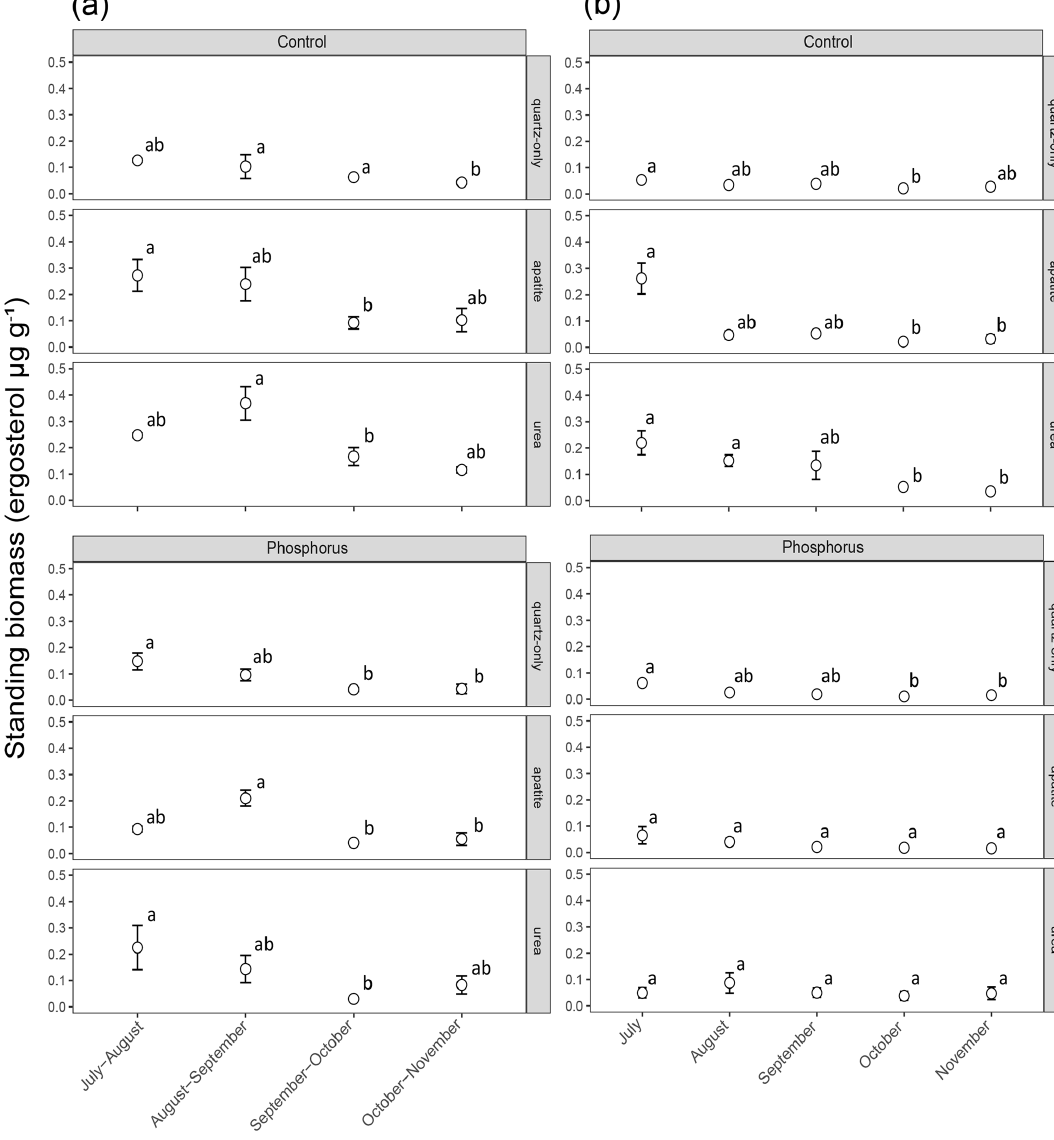
Figure 2. Standing EMF biomass in the mesh bags that have been in the soil for a period of 2 months (a) and a period of 1 month (b) . The error bars represent the standard error of the mean ( n = 3). Lowercase letters represent statistically significant ( P < 0.05) differences between the incubation periods according to Dunn’s